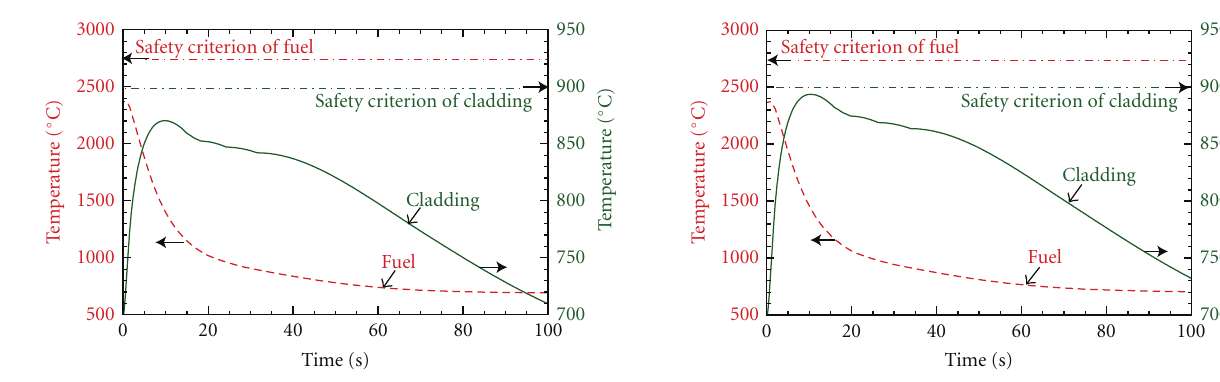
Figure 4: Primary pump seizure accident with primary RSS. Figure 5: Primary pump seizure accident with backup RSS.